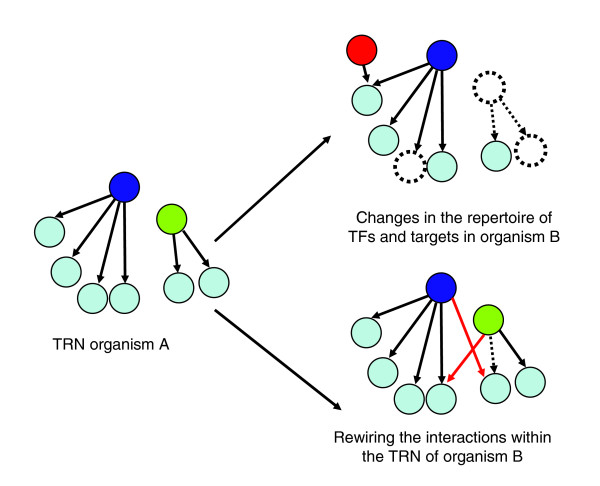
Schematic representation of the two parallel pathways by which the TRN evolves. Changes in the network may be achieved by removal or addition of TFs and/or targets, by rewiring of the network, or by both mechanisms.